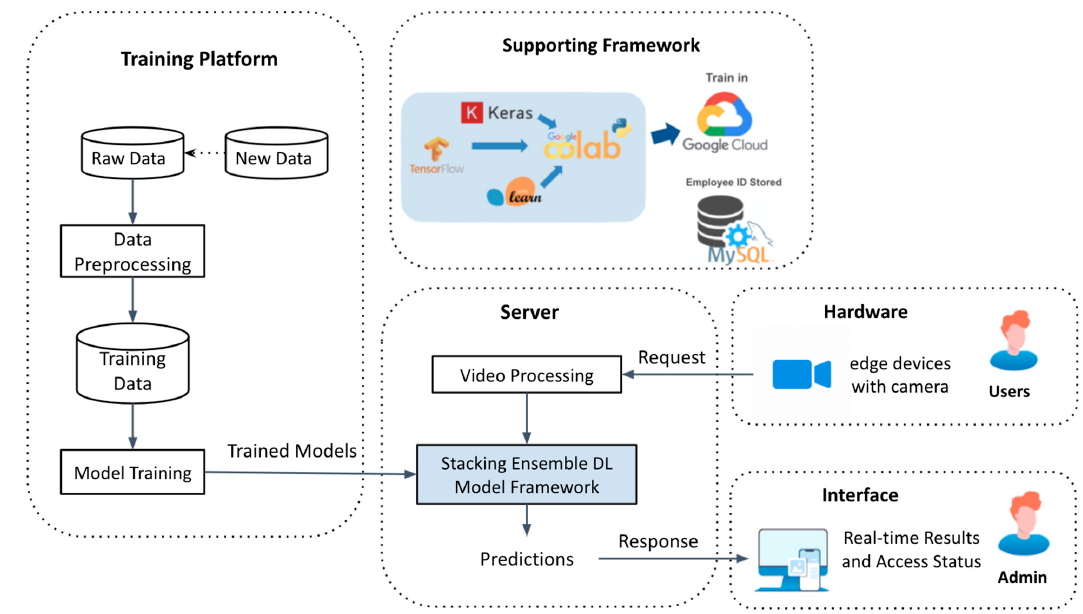
Figure 15. Block Diagram of Spartan